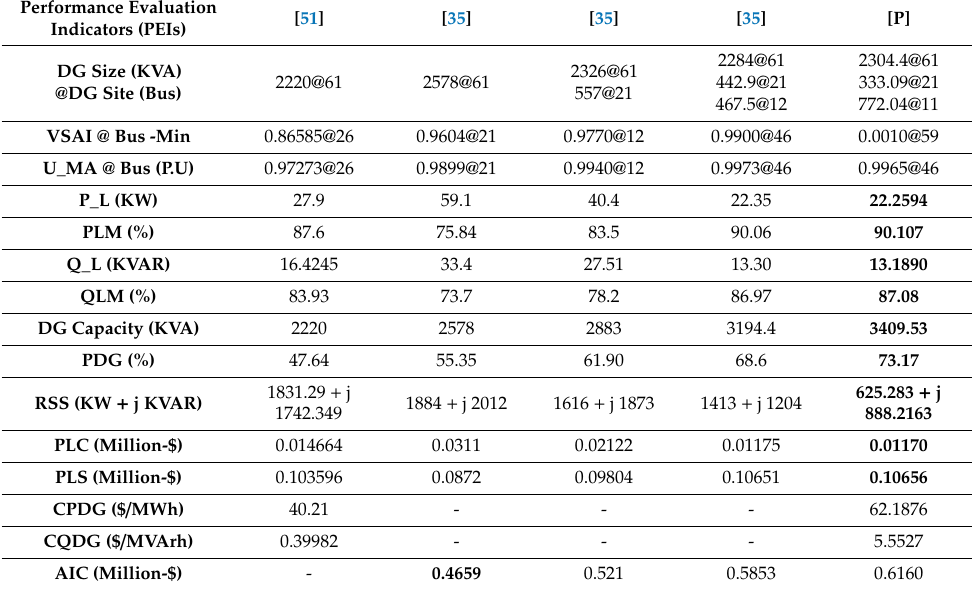
Table 15. Comparisons of results with various scenarios of C6 / S1 for a 69-bus test system (DG@PF = 0.90 ±